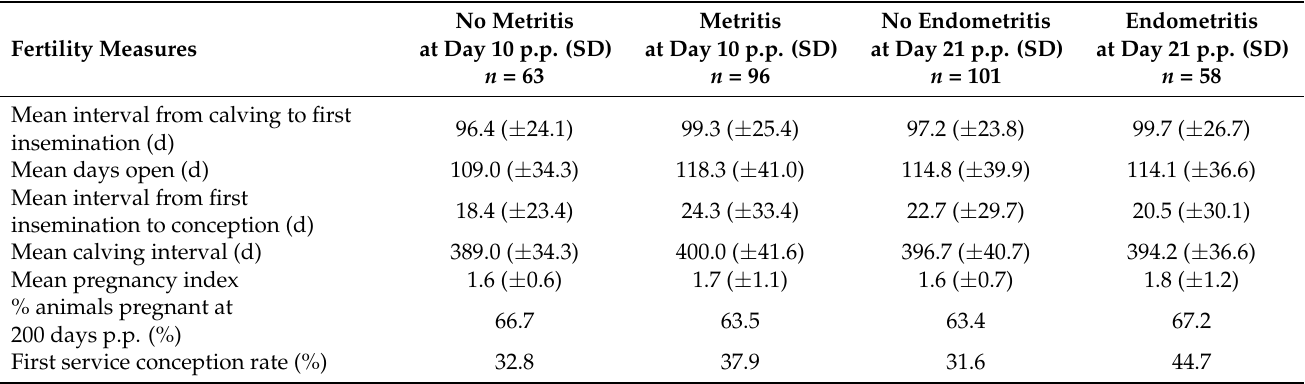
Table 7. Fertility measures in heifers with or without metritis at day 10 p.p. or endometritis at day 21 post partum (SD = standard deviation, p.p. = post